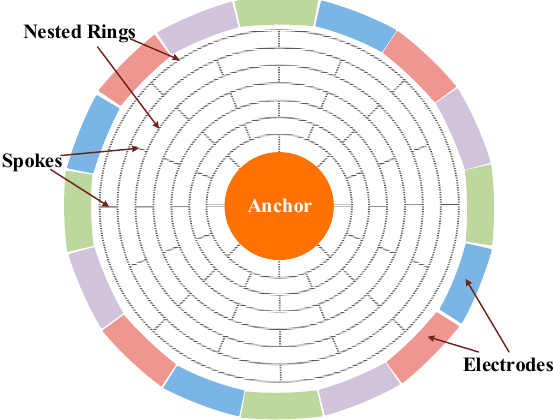
Figure 1. A standard model of the sensitive structure for the microelectromechanical systems disk resonator gyroscope (MEMS DRG) .